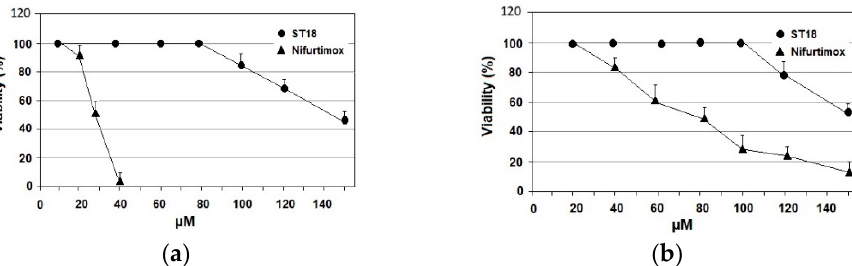
Figure 2. Cytotoxic effects of compounds ST18 and Nifurtimox in mammalian cells. ( a ) Cytotoxic effects of compounds ST18 and Nifurtimox in primary epithelial cells of Cercopiteco (CPE). ( b ) Cytotoxic effects of compounds ST18 and Nifurtimox in U937 macrophage cells. Bars indicate the means ± SEs from four independent experiments. Data obtained are statistically significant at p < 0.05.